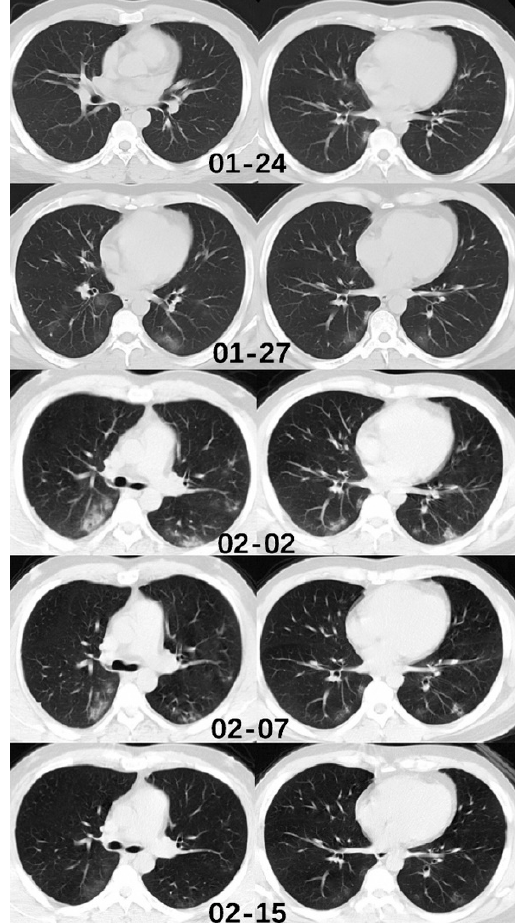
Figure 3. Chest CT of a 37-year-old male patient. This individual returned from Wuhan to Wenzhou on January 19 and inflicted with cough and expectoration. The first chest CT was conducted on January 24, which showed subtle peripheral ground-glass opacity in the middle lobe, and right inferior lobe. The second CT images, of January 27, and the third examination, on February 2, showed a significant increase of lesion numbers and density, especially in both lower lobes. The fourth CT images, of February 7, showed a decrease in the density of the pulmonary lesions. On the fifth CT examination of February 15, the lesions were absorbed, and the patient was discharged [52]. Reprinted (adapted) with permission from Elsevier.